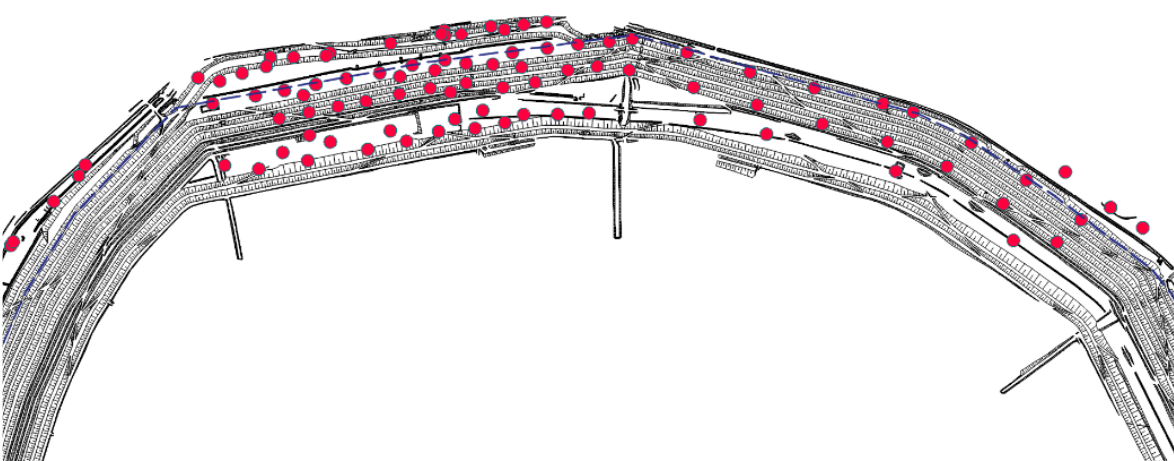
Figure 3: Locations of relief wells in the considered